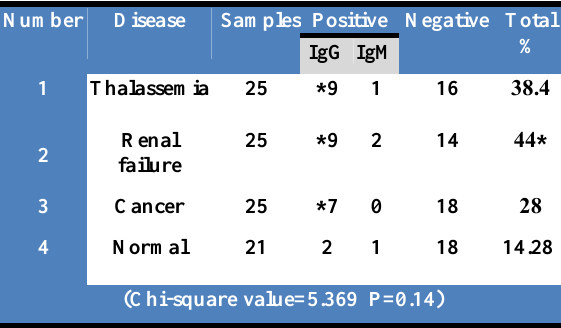
Table, 2: Differences between proportions (IgG, IgM and total) of Toxoplasmosis in men suffering from different chronic diseases.